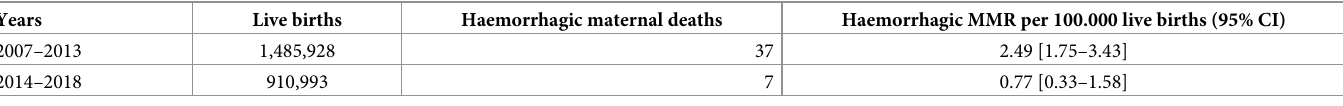
Table 1. Maternal mortality ratio due to obstetric haemorrhage in five Italian regions (Piedmont, Emilia-Romagna, Tuscany, Lazio and Sicily). Years 2007–2018.